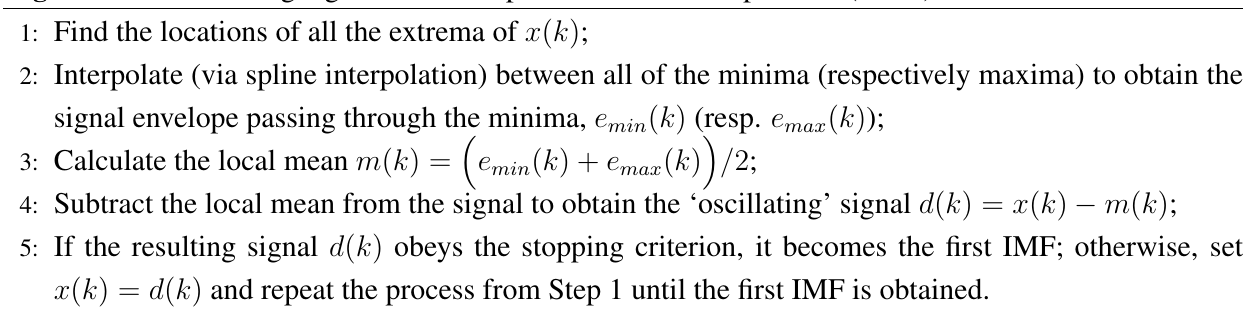
Algorithm 1 The sifting algorithm for empirical mode decomposition